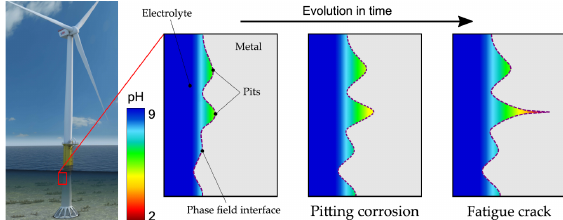
Figure 5. Capturing morphological changes in the electrolyte-metal interface using phase field: from pitting corrosion to the initiation and growth of fatigue